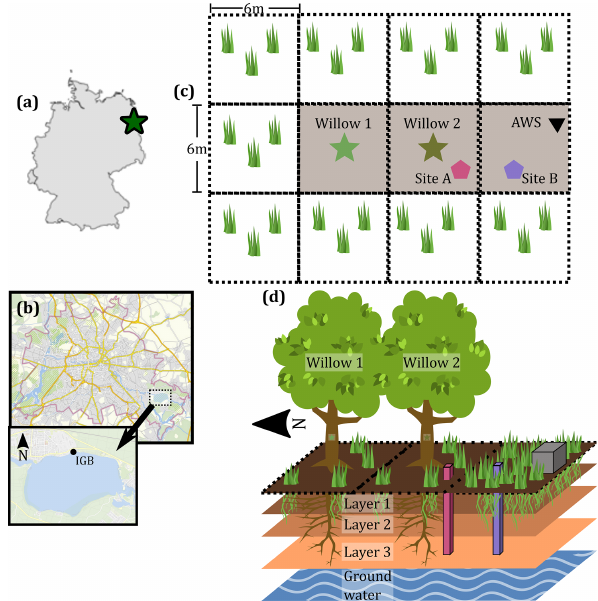
Figure 1. Study site location and site description. (a) Location of the site within Germany. (b) Location of IGB within Berlin (2021). (c) Plan view of the study site including the location of the willow trees, soil water isotope and moisture, and automatic weather sta- tion (AWS). (d) Conceptual diagram of the study site, with three soil depths and two primary vegetation units (with relative prominence). Pink and blue columns in (d) indicate soil moisture and isotope measurement columns, and grey box indicates AWS location. Berlin maps © OpenStreetMap contributors, 2021. Distributed under the Open Data Commons Open Database License (ODbL) v1.0. The area surrounding the study site is grass covered, similar to Site